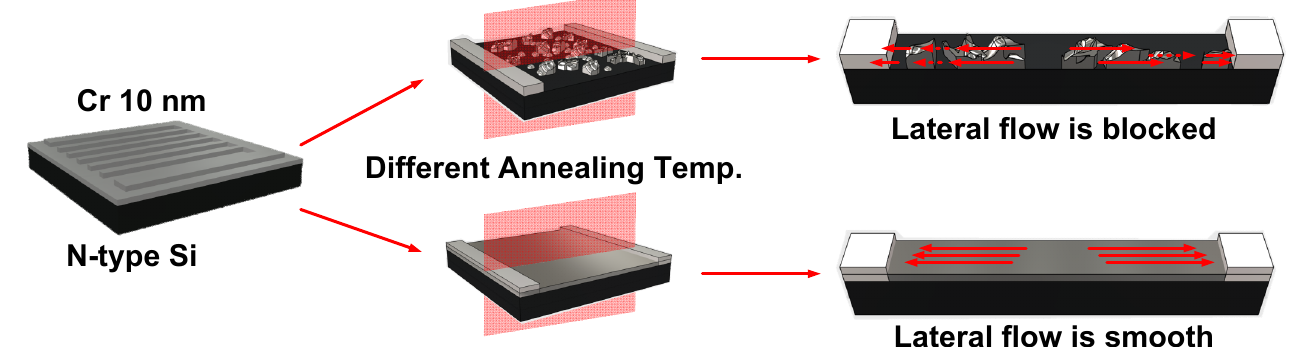
Figure 7. The uniform surface and the island-distributed surface.